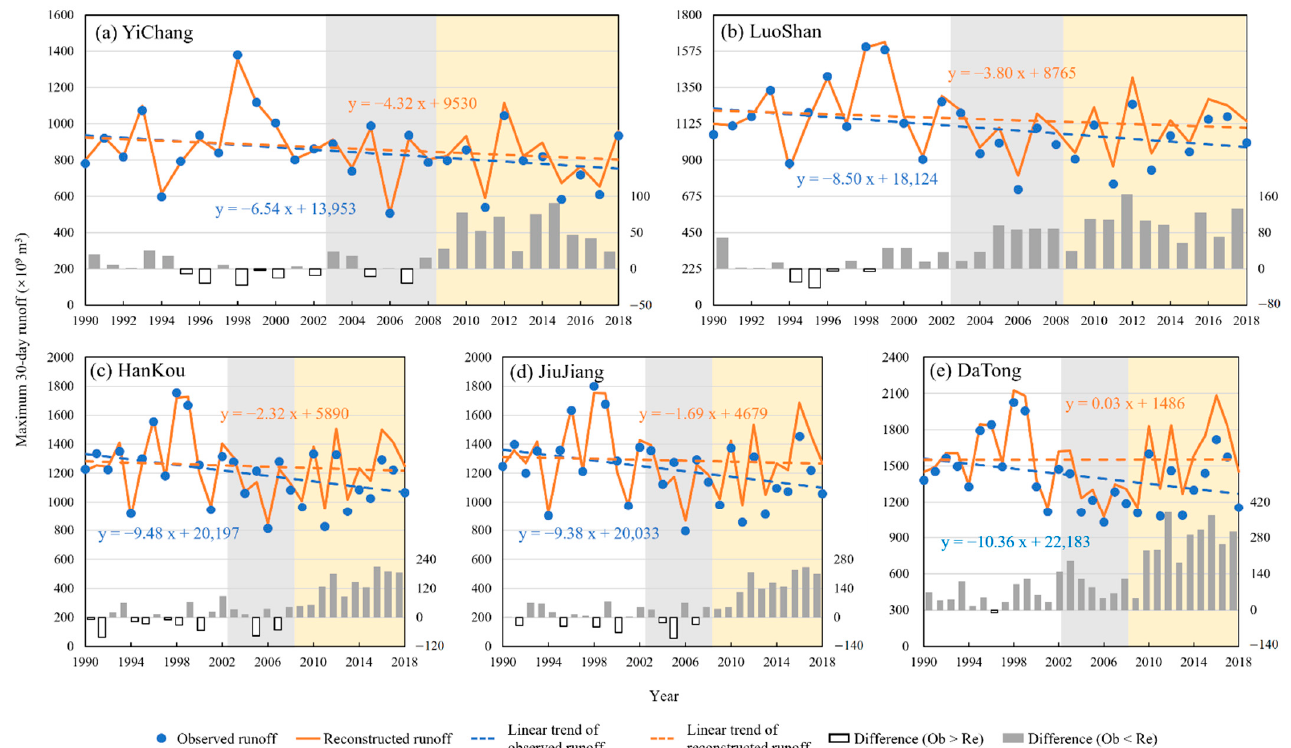
Figure 9. Analysis of the maximum 30-day runoff during flood season in the five gauging stations (the grey zones denote the initial operation period of the TGD from 2003 to 2008, and the yellow zone denotes the full operation period of the TGD from 2009 to 2018).